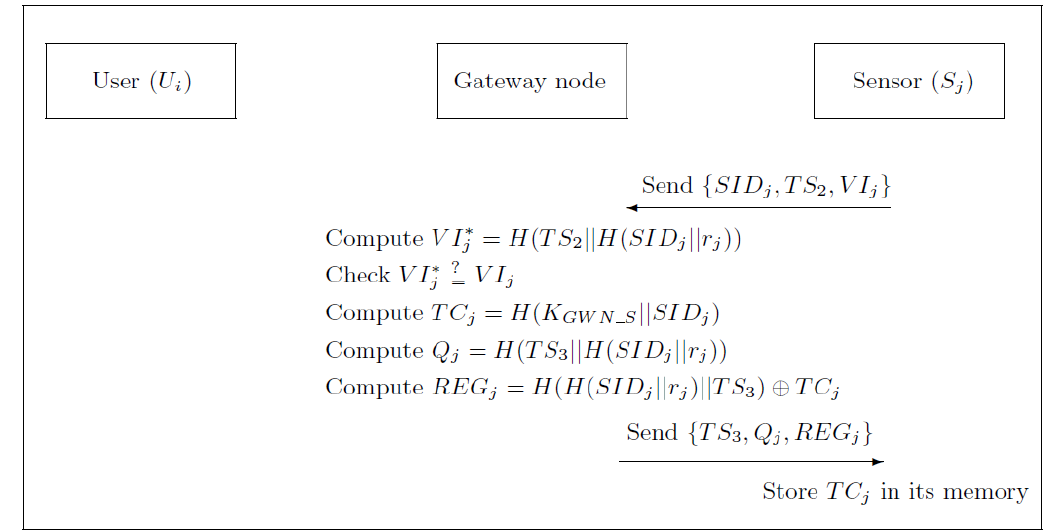
Figure 1. Communication handshakes of the registration phase of the user U